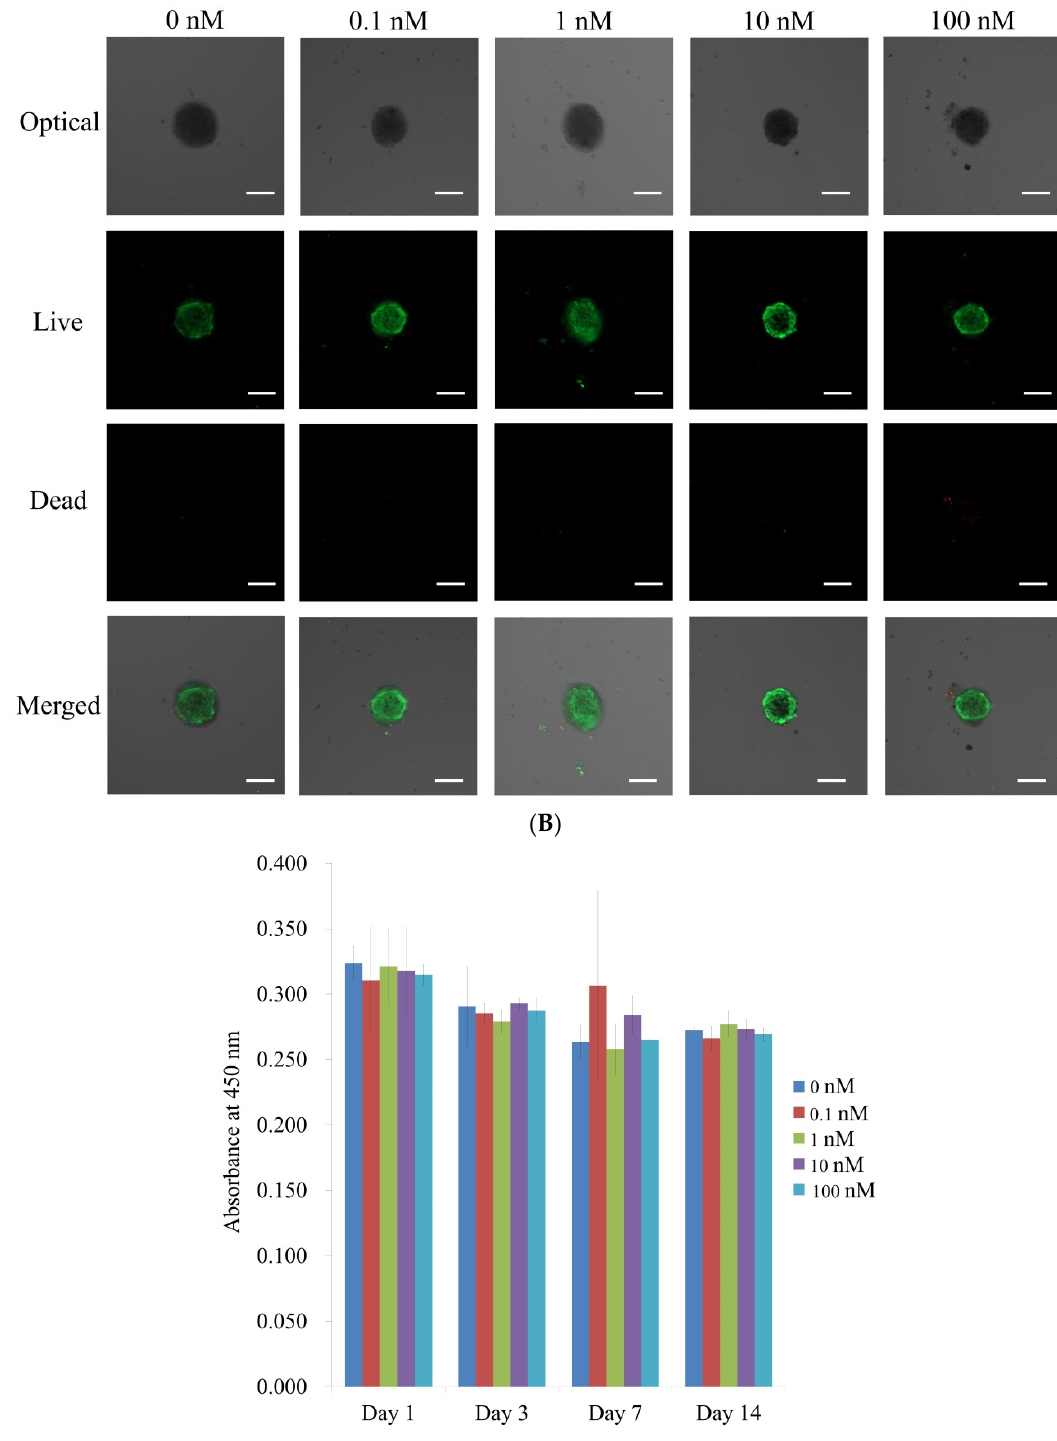
Figure 3. ( A ) Optical, live, dead, and merged cell images of stem cell spheroids on day 1. ( B ) Optical, live, dead, and merged cell images of stem cell spheroids on day 7. The scale bar represents 100 µm (original magnification ×100). ( C ) Cell viability using Cell Counting Kit-8 on days 1, 3, 7, and 14.